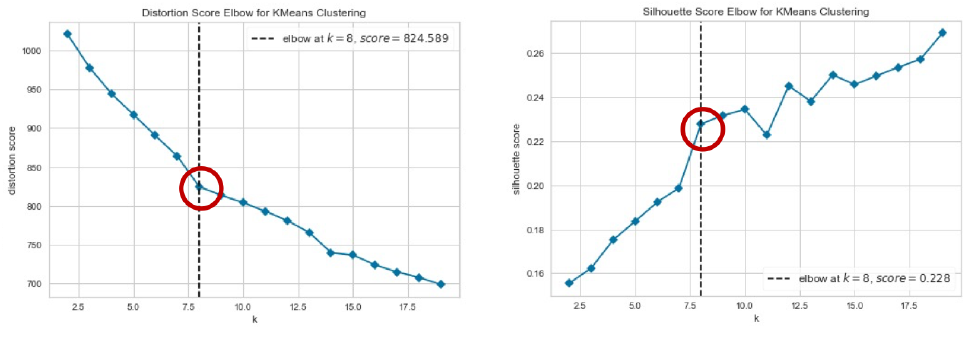
Figure 8. AliDPG—number of clusters. k values with the Elbow method on the left side and the silhouette coefficient score on the right